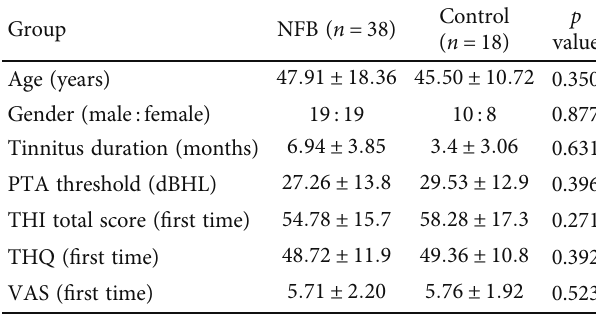
Table 1: Patient